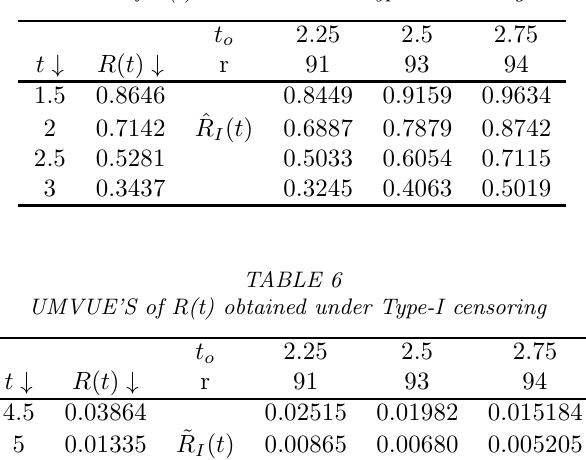
MLE’s of R(t) obtained under Type-I censoring